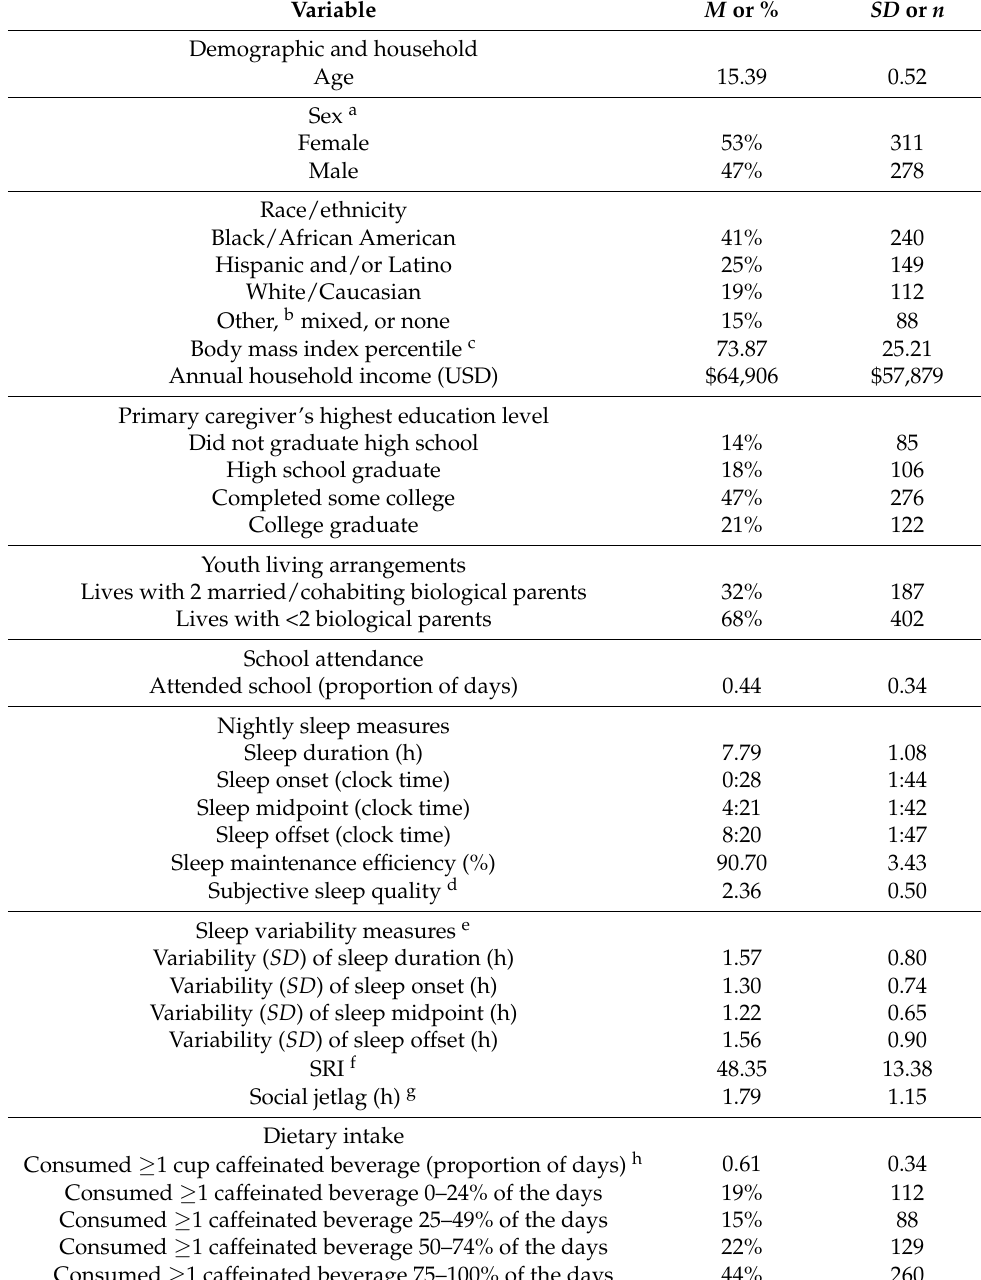
Table 1. Average descriptive statistics for analytical sample ( n =